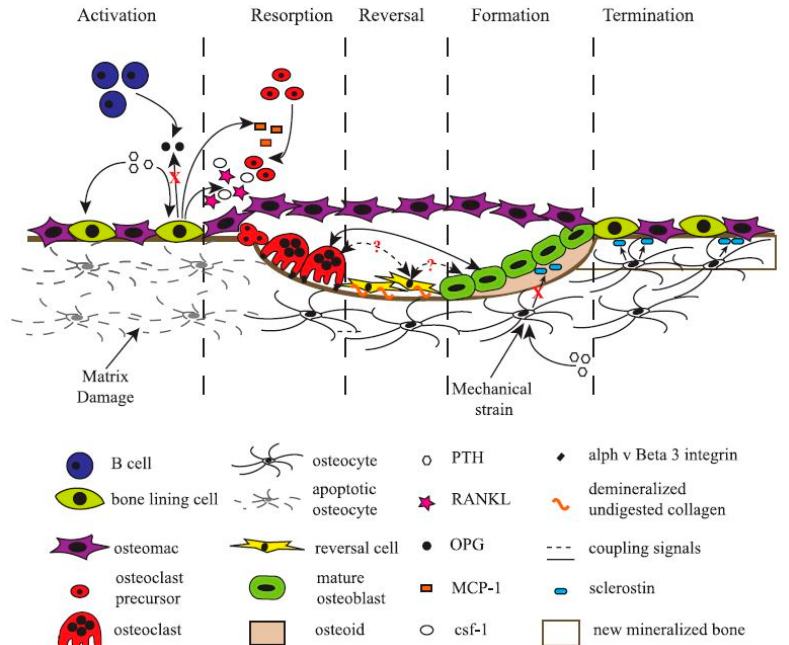
Figure 2. Schematic representation of a basic multicellular unit and the associated bone remodelling process. Permission obtained from ASBMB. © Liza J. R. and Nicola C.P. J. Biol. Chem. 285: 25103 (2010).